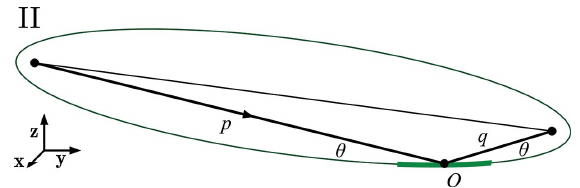
Figure 4 The Type II ellipsoid geometry is the most convenient description for modeling, fabrication, and testing. The coordinate origin is placed at the central point of intersection, where the surface is tangent to the xy plane. Shown is the cross section through the yz , meridional plane. The direction of light propagation is